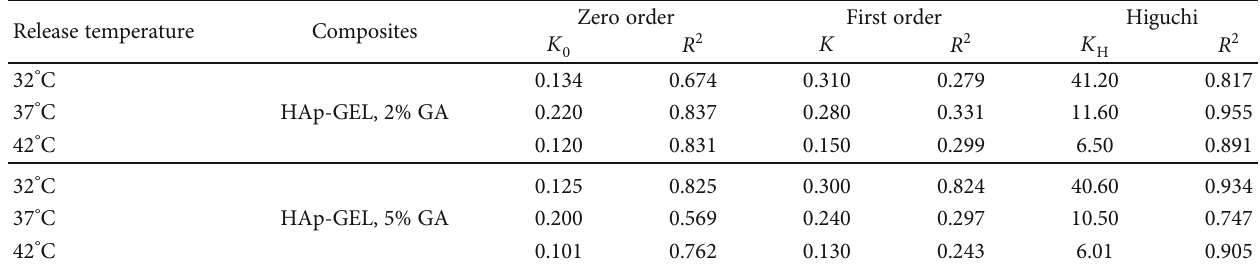
, K , and K ) of various models for the release of 5-FU from the drug-loaded HAp-GEL polymer 0 H